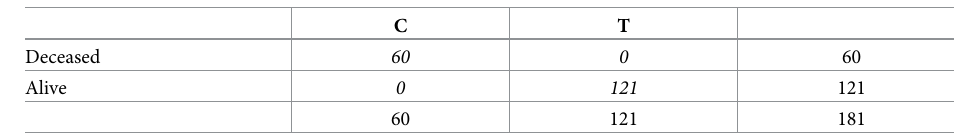
Table 4. Ethical